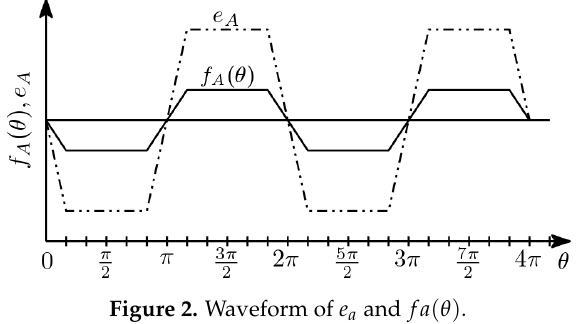
Figure 2. Waveform of e a and f a ( θ )